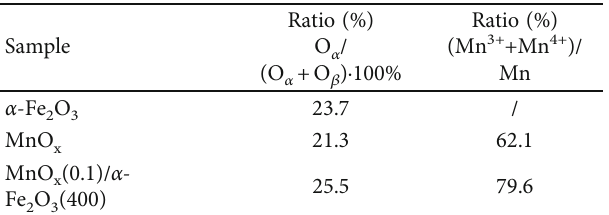
Figure 5: XPS spectra of (a) Fe 2p, (b) Mn 2p and (c) O 1 s of α -Fe Table 3: The ratio of O samples by XPS